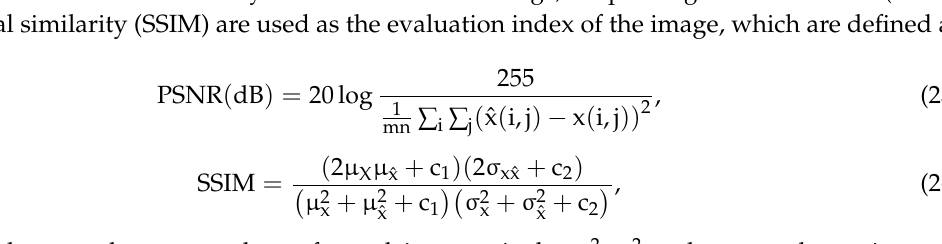
Table1. The quantitative results of different algorithms. Algorithm